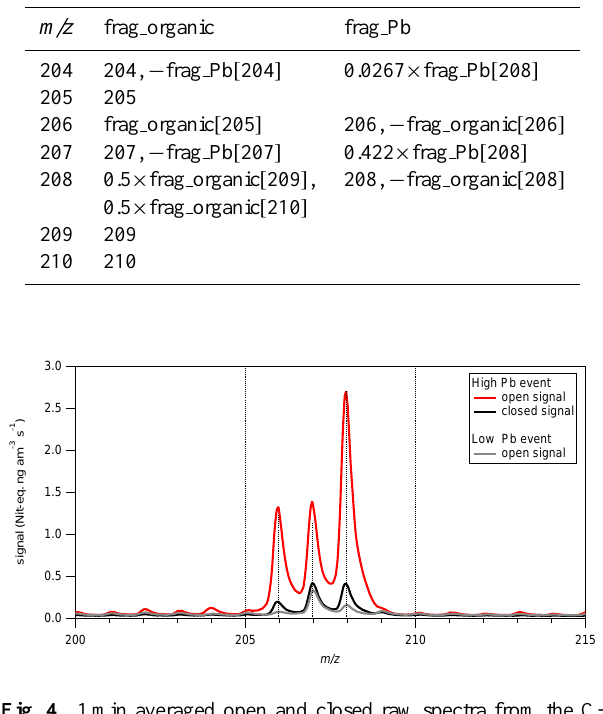
Fig. 4. 1min averaged open and closed raw spectra from the C- AMS for a high and a low Pb event. The position of the dashed vertical lines indicate the exact mass of the 206 Pb, 207 Pb, and 208 Pb and their height, the relative abundance of the three Pb isotopes.